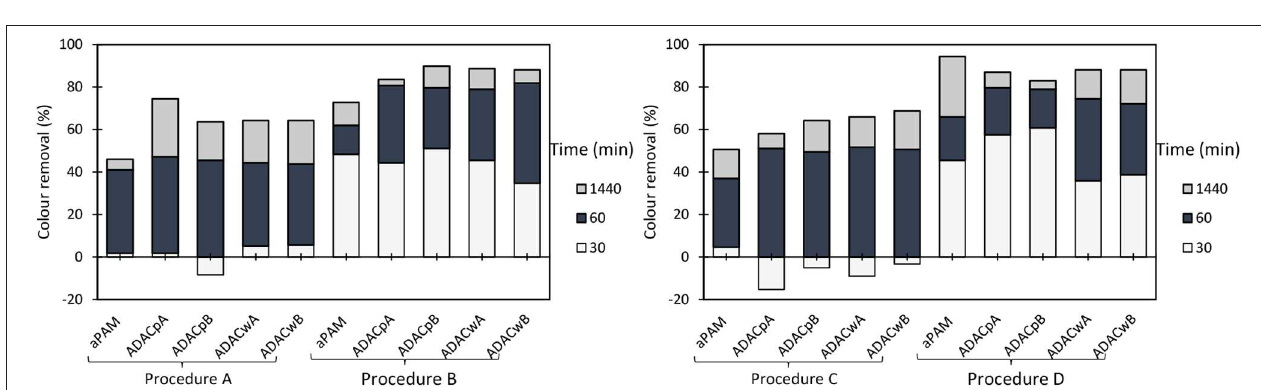
FIGURE 7 | COD reduction and turbidity removal during the industrial effluent treatment with CDAC p A, B and CDAC w A, B and reference Snow Flake E2 (cPAM), at pH 3.0, after 24h of treatment, in two conditions: (A) 0.3 wt% bentonite followed by 2.67 mg/L of flocculation agent and (B) 0.6 wt% bentonite followed by 5.34 mg/L of flocculation agent.